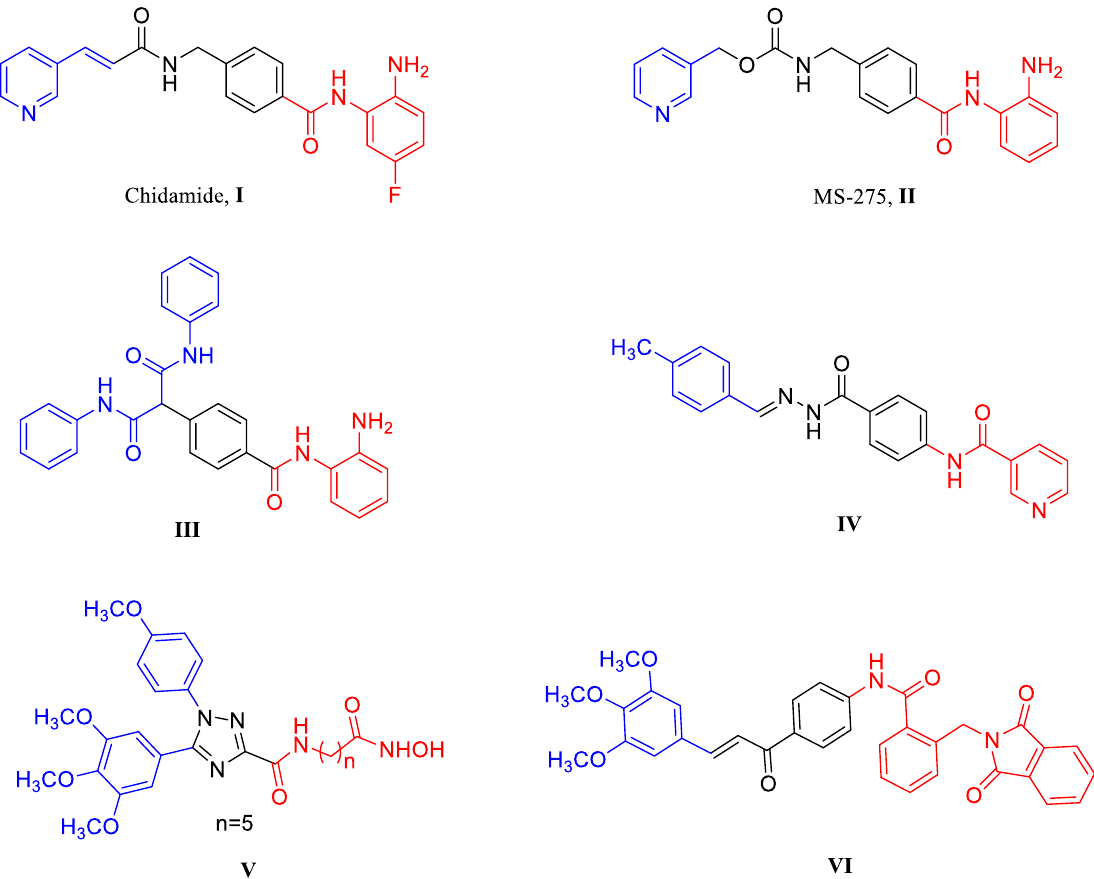
Figure 1. The structures of HDAC inhibitors in clinical trials ( I – IV ) and dual HDAC-tubulin inhibitors ( V and VI ). Cap group showed in blue color and zinc binding group showed in red color.